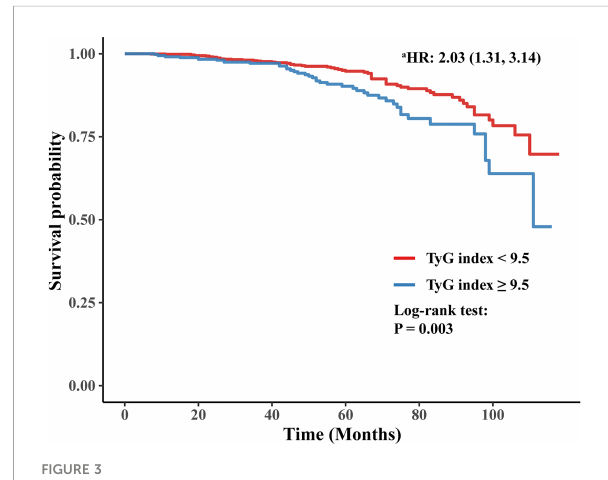
FIGURE 3 Kaplan-Meier curve of time to incident ESRD. a : adjusting for sex, age of DM onset, duration of diabetes, hyperlipidemia, treatment of lipid-lowering drugs, smoking status, insulin treatment, HF, eGFR, MAP, BMI, anemia, urinary protein, LDL, and